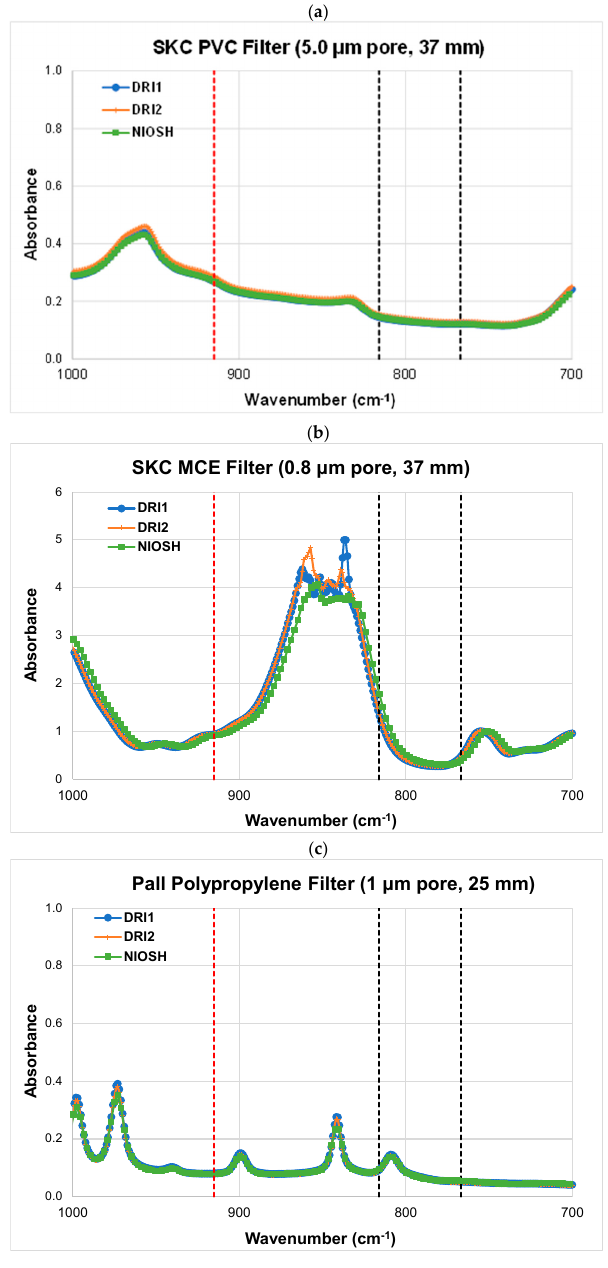
Figure 5. Comparison of blank membrane filters between the NIOSH (Spokane, WA, USA) and DRI (Reno, NV, USA) laboratories for: ( a ) PVC, ( b ) MCE, and ( c ) polypropylene filters. The two vertical black dashed lines bracket RCS absorption from 767 to 816 cm − 1 . The vertical red dashed line repre- sents the wave number (915 cm − 1 ) for correcting kaolinite absorption interference for RCS determi- nation.